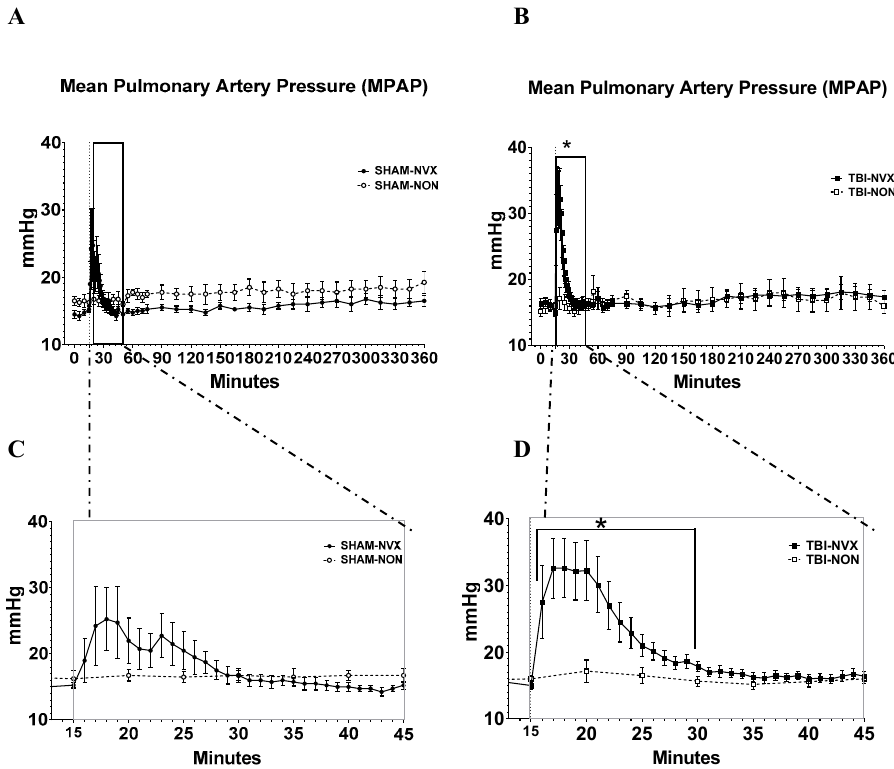
Figure 2. Mean pulmonary arterial pressure. Data (mean ± SEM) for the entire observation period ( A , B panels, SHAM and TBI groups respectively) and expanded data for the first 45 min ( C , D panels, SHAM and TBI groups respectivelyTBI-NVX was different from TBI-NON) between T15 and T30 (* p < 0.05); there were no differences between the SHAM groups.